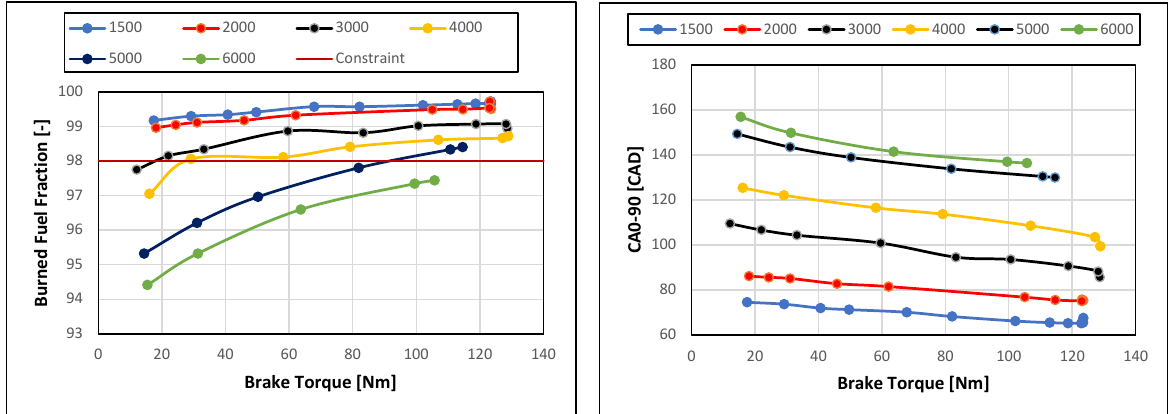
Figure 6. Burned fuel fraction ( left ) and CA 0 – 90 ( right ) for different regimes. No boost.